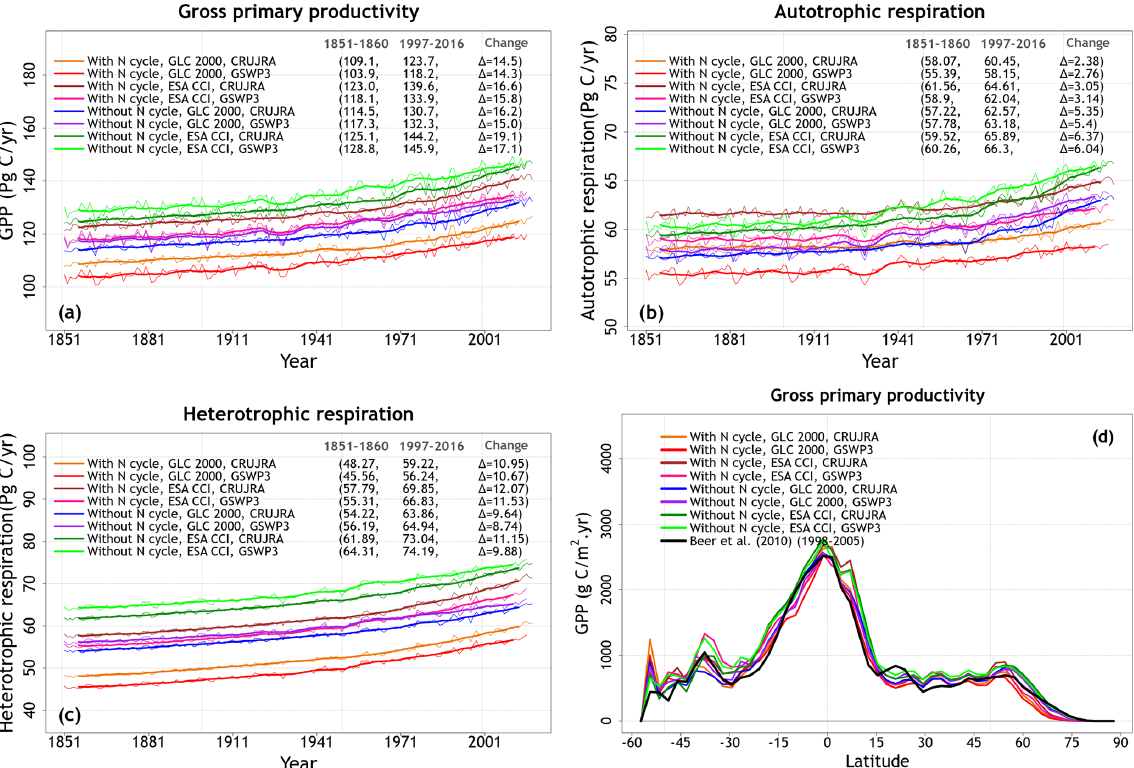
Figure A7. Time series of simulated global annual gross primary productivity (GPP) (a) , autotrophic respiration (b) , and heterotrophic respiration (c) from the eight simulations summarized in Table 1; (d) shows the zonally averaged values of GPP from the eight simulations averaged over the 1997–2016 period for each simulation. The thin lines show the individual years, and the thick lines show their 11-year moving average in (a) to (c) . Model values averaged over the pre-industrial (1851–1860) and present-day (1997–2016) time periods, and their difference, are also shown in (a) to (c)